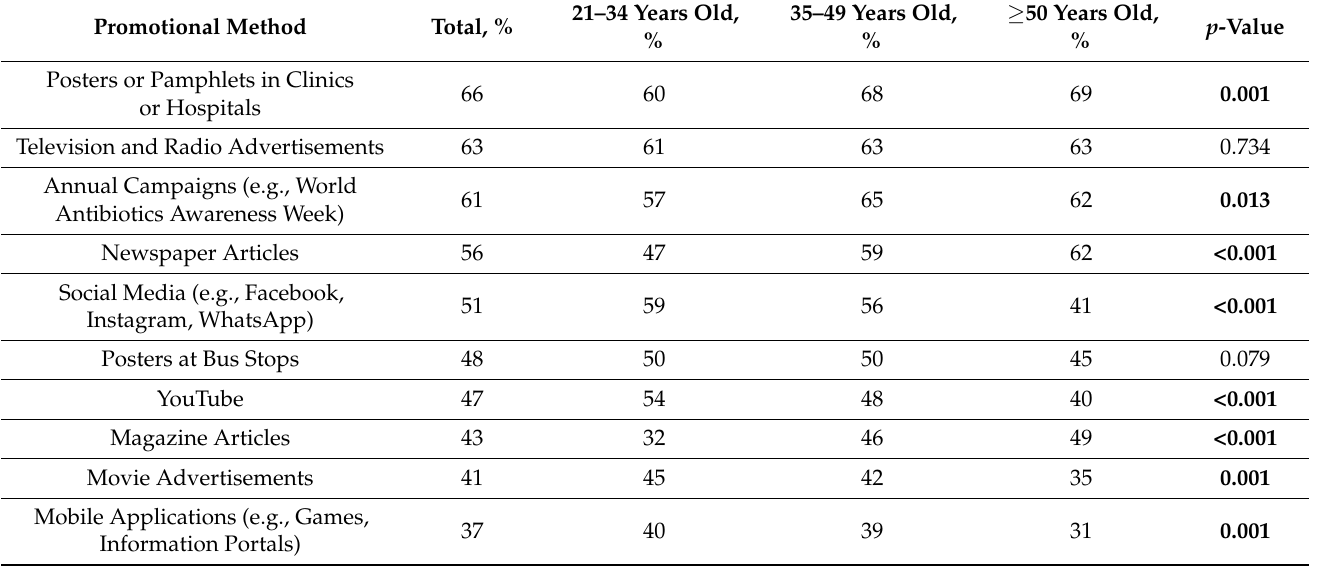
Table 6. Proportion of 2004 Singapore residents on their perceived effectiveness for a list of promo- tional methods to educate on AMR, stratified by age